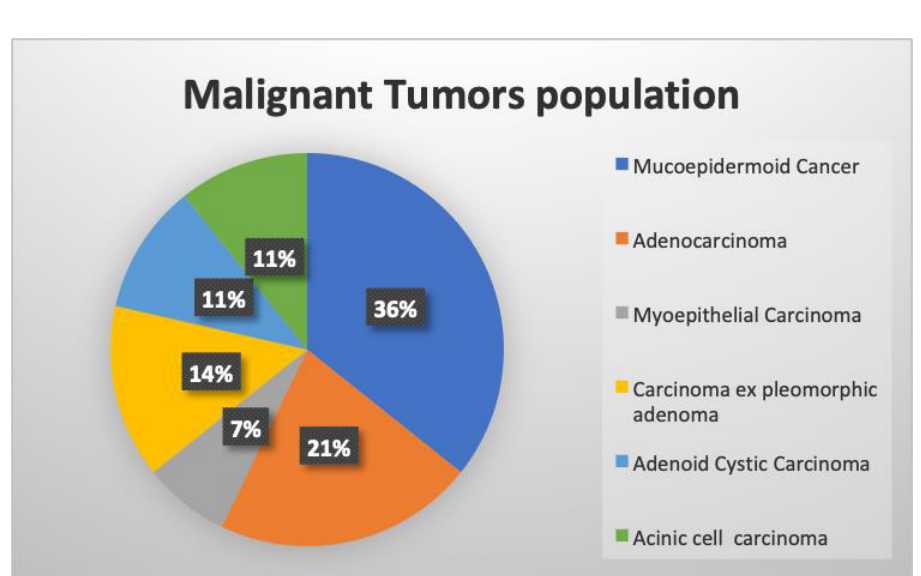
Figure 2. Main histopathological types of the malignant population